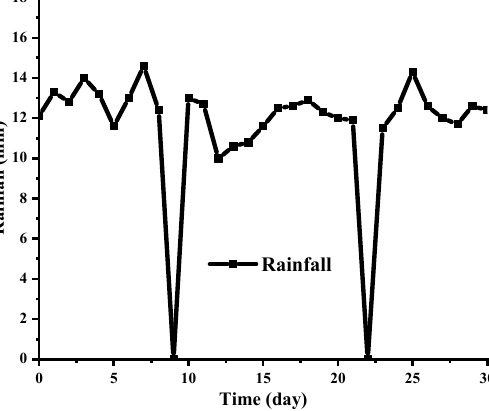
Figure 2. Grid model.